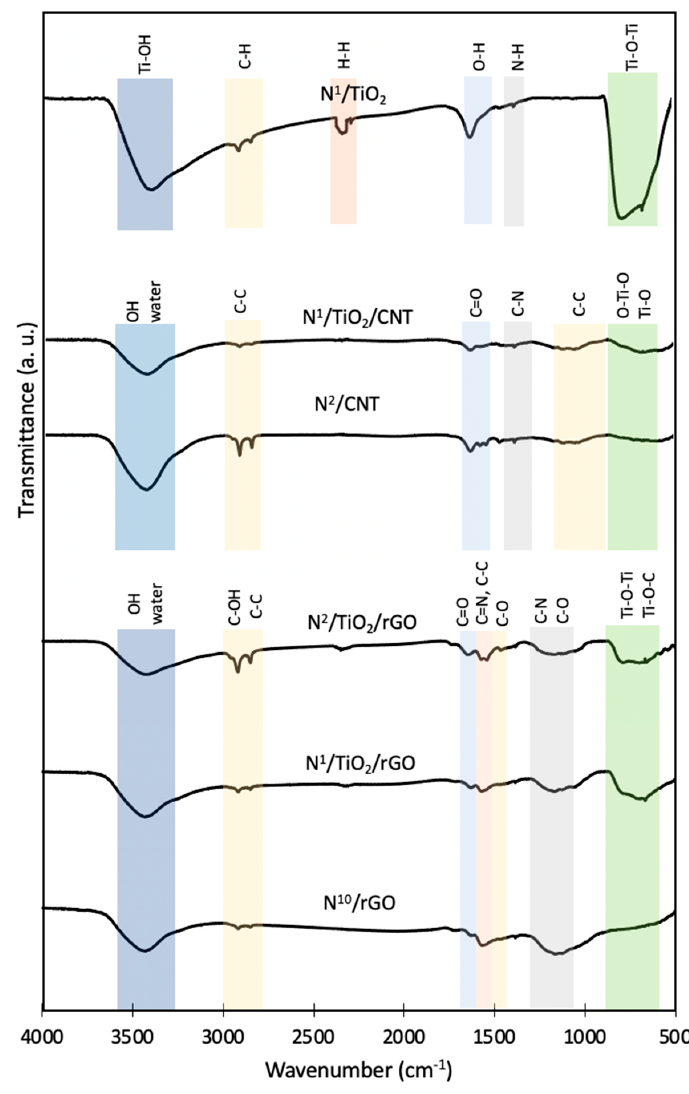
Figure 5. FTIR spectra of different synthesized N – doped TiO 2 – based photocatalysts and supports. In addition to the striking peak at 3400 cm − 1 related to OH groups and mentioned in the two previous cases, N-doped rGO and TiO 2 /rGO composites exhibited signals at 2800, 1625 and 1500 cm − 1 associated with the stretching of C-OH, the presence of C=O and the deformation of C-O groups of rGO [43]. The 2800 cm − 1 signal could overlap with C-C signals at 2852 and 2919 cm − 1 [44]. These surface oxygen-containing functional groups render the possibility of covalent linkage of TiO 2 onto the rGO surface [45]. The main difference between N-doped TiO 2 /rGO composites and rGO is the band at 650 cm − 1 related to the Ti-O-Ti bonds. The broadening of this peak may suggest the presence of a peak due to Ti-O-C bond. This confirms that TiO 2 nanoparticles could be strongly bonded to graphene sheets [34]. In addition, the peaks at about 1360 and 1550 cm − 1 showed the possible presence of C-N bond from pyrrolic nitrogen (interstitial) and C=N from pyridinic nitrogen (substitutional), respectively [46]. Although they can also be related to C-O and C-C bond bands, respectively [47]. N 2 /TiO 2 /rGO catalyst does not show any difference with the composite with lower N content.